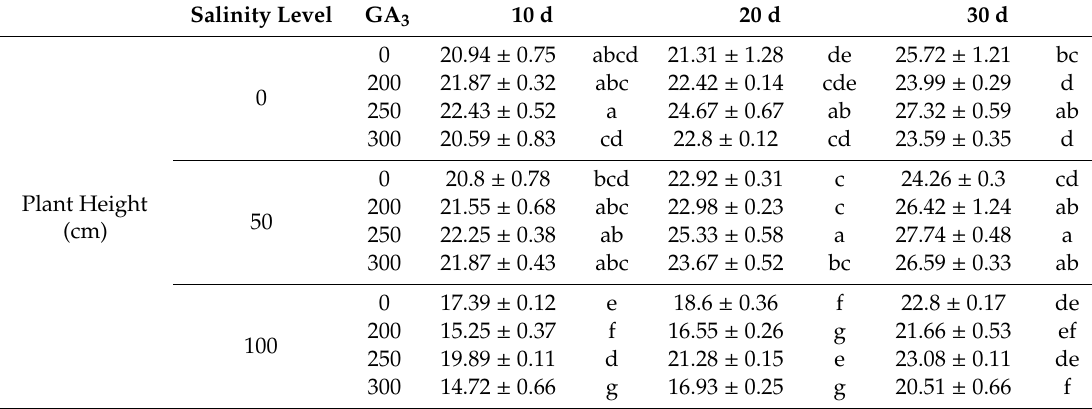
Table 1. E ff ects of di ff erent levels of exogenous gibberellic acid (GA 3 ) on plant height of caster bean seedlings grown under three levels of NaCl treatment: 0 (control), 50, and 100